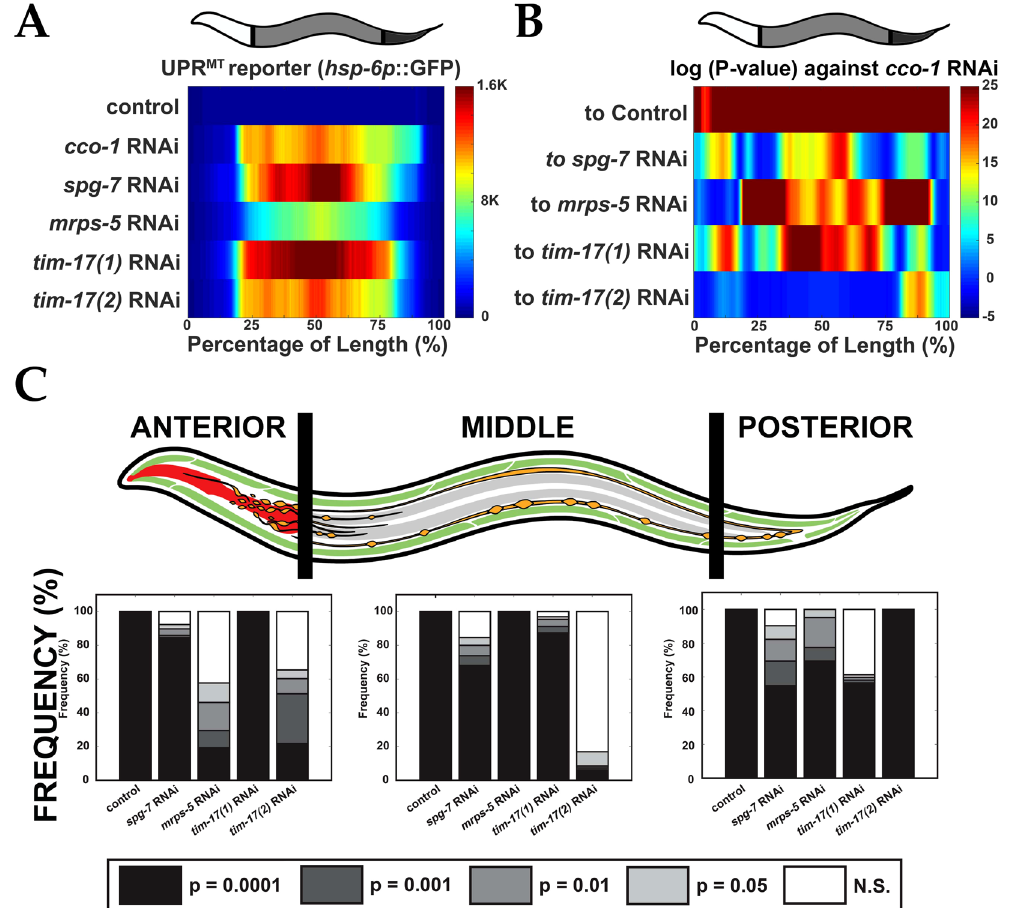
Figure 3. Longitudinal quantification of transcriptional reporter. ( A ) Median profiles of UPR mt after induction of the mitochondrial unfolded protein response (UPR mt ) by various RNAi treatments. ( B ) Significance plot (log 10 ( P-value )) derived from median profiles in ( A ) comparing all profiles to “ cco-1 RNAi” (downregulation of Complex I). For significance plots a value ≥ 0 is equivalent to P ≤ 0.05 by Wilcoxon Rank Sum Test. ( C ) Frequency plots for the percentage of bits in each region of the worm (left) that correspond to varying degrees of significance by Wilcoxon Ran Sum (white = not significant “N.S.”; light grey = P < 0.05; medium grey = P < 0.01; dark grey = P < 0.001; black = P < 0.0001). Comparisons are made for each of these regions against “ cco-1 RNAi”. All animals are positioned with the anterior side to the left. Plots are representative of three biological replicates and derived from n ≥ 50 organisms. Sample size ( n ) for all experiments and exact P-values can be found in the Supplementary Table. L.A. Daniele provided the